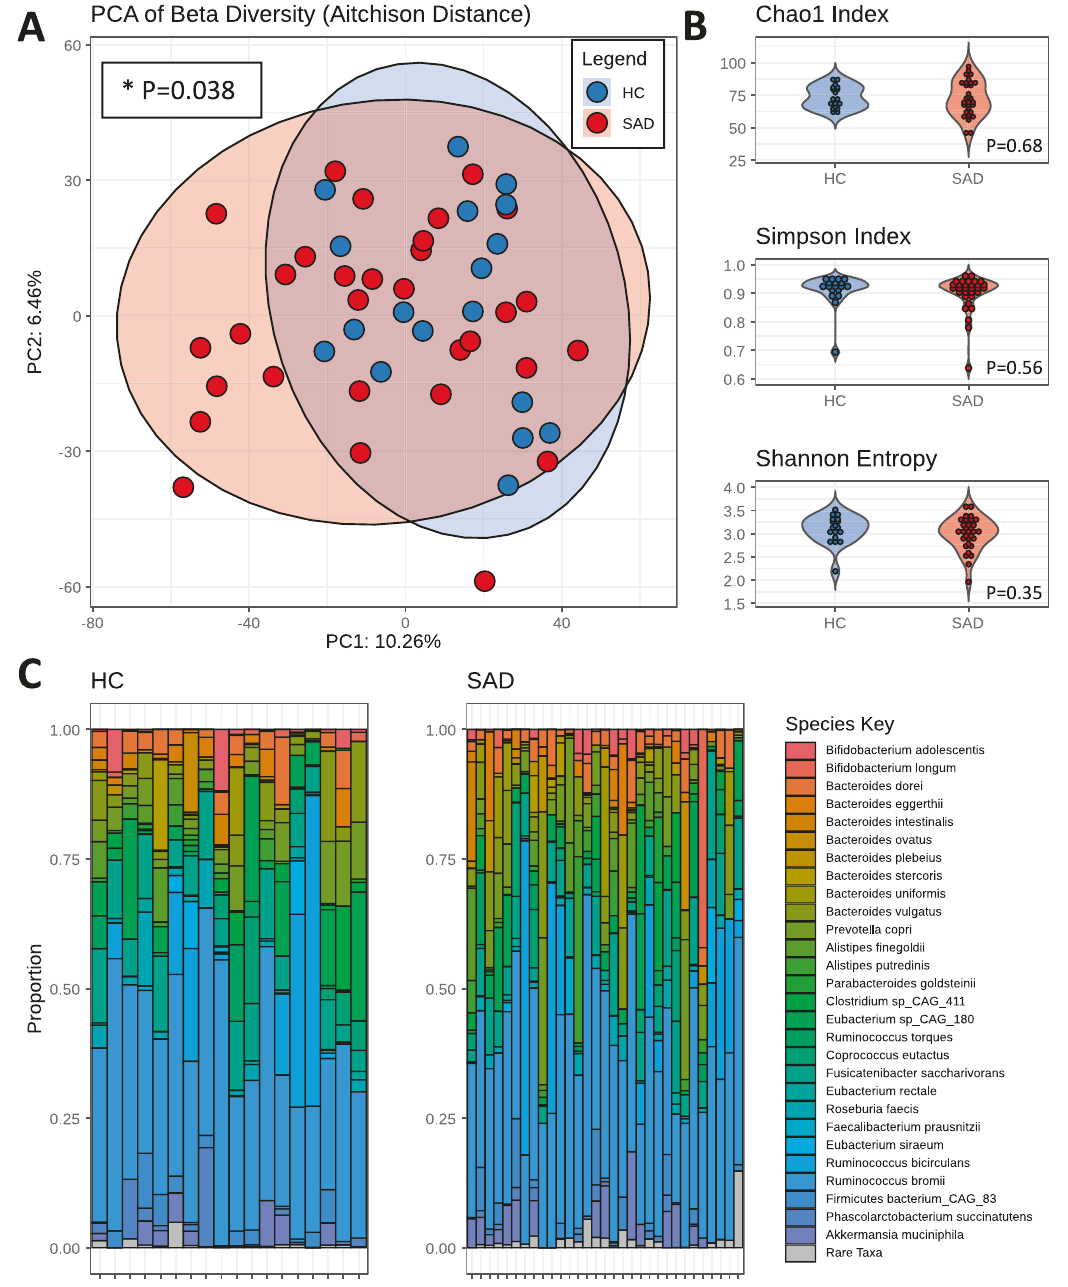
Fig. 1 Gut Microbiota differences between SAD and control groups. A Beta diversity between SAD and healthy control groups, as measured by Aitchison Distance. p-value based on PERMANOVA test. B Alpha-diversity between SAD and healthy controls, as measured by Chao1, Simpson and Shannon indices. p-values based on Student ’ s t-tests. C Relative abundance of species-level taxa for each participant. Each column represents one participant. Genera that were never detected at a 10% relative abundance or higher are aggregated and de fi ned as rare taxa for the purposes of the stacked barplots. (* p = <0.05) (HC: Healthy Control, SAD: Social Anxiety